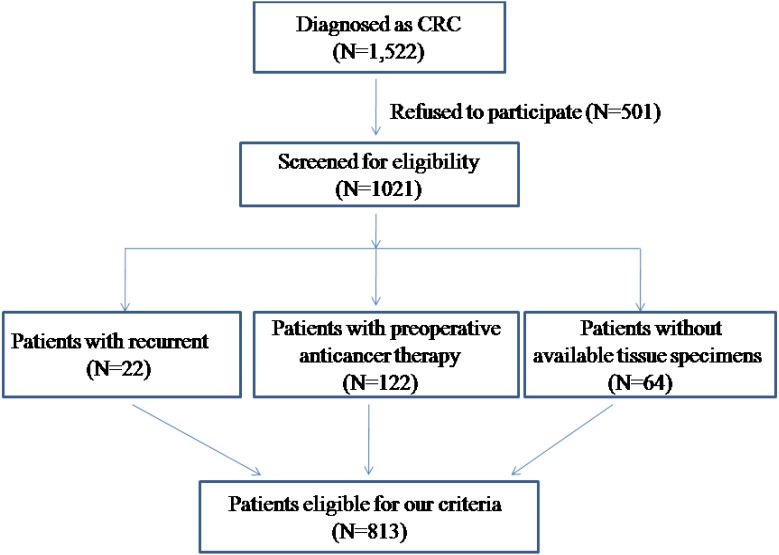
Consort diagram in patient selection.